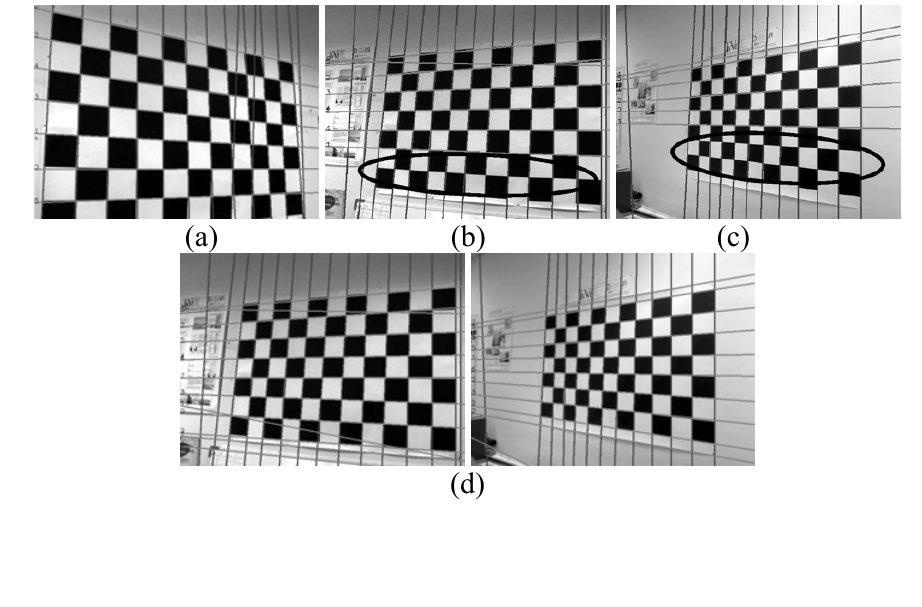
Figure 11. Detection of sets of lines (a) correct detection (b-c) erronous detection (d) correct